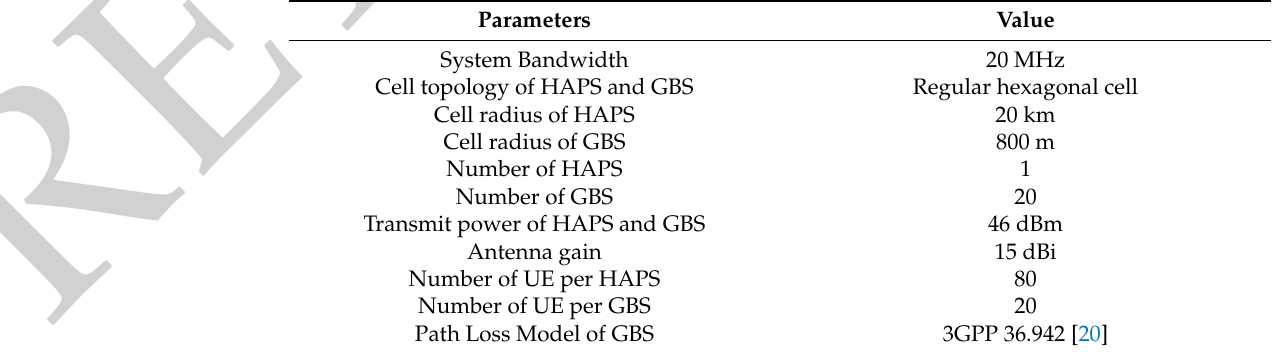
Table 2. Simulation